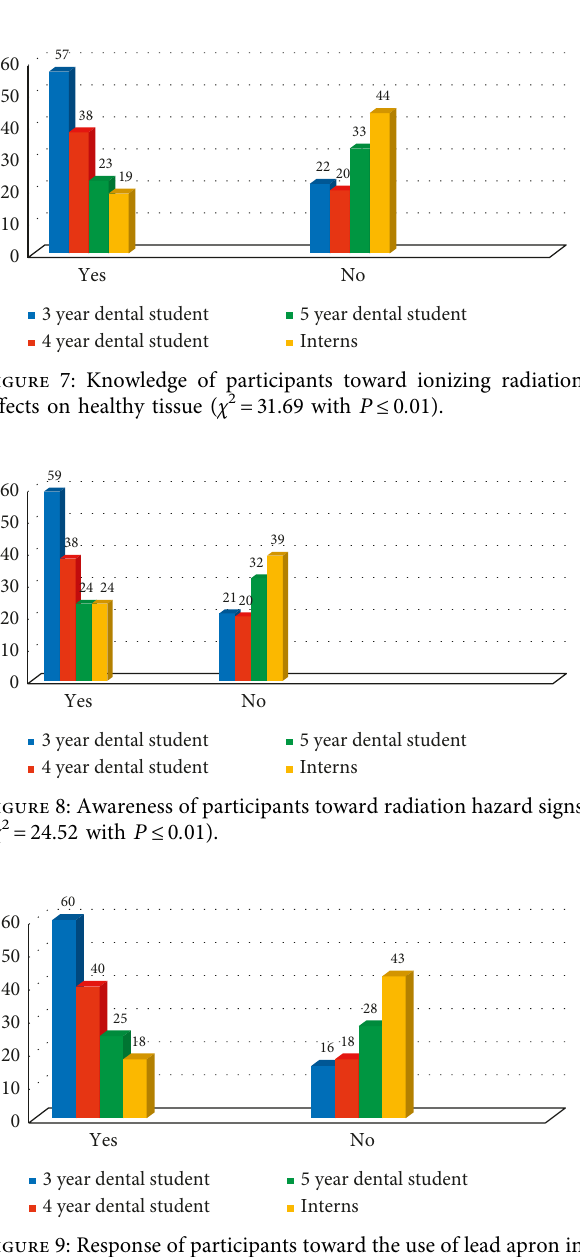
Figure 9: Response of participants toward the use of lead apron in 39.34 with P 0 . regular basis ( χ 2 (cid:31) ≤